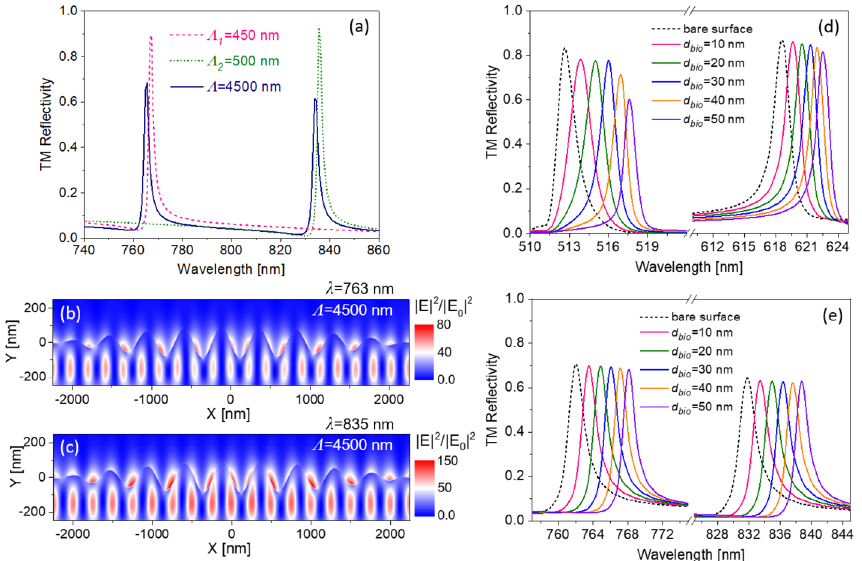
Figure 2. ( a ) TM-polarized reflectivity spectrum as a function of wavelength ( λ ) for the biperiodic waveguide structure with a superimposed period of Λ = 4500 nm. ( b , c ) Normalized electric field intensity profiles above and within such a waveguide with Λ = 4500 nm at two distinct resonant wavelengths. TM-polarized reflectivity curves for ( d ) the single-period grating ( Λ = 350 nm) with two independent (leaky mode and waveguide mode) resonances, and the same for ( e ) biperiodic structure ( Λ = 4500 nm) with two independent resonances due to leaky